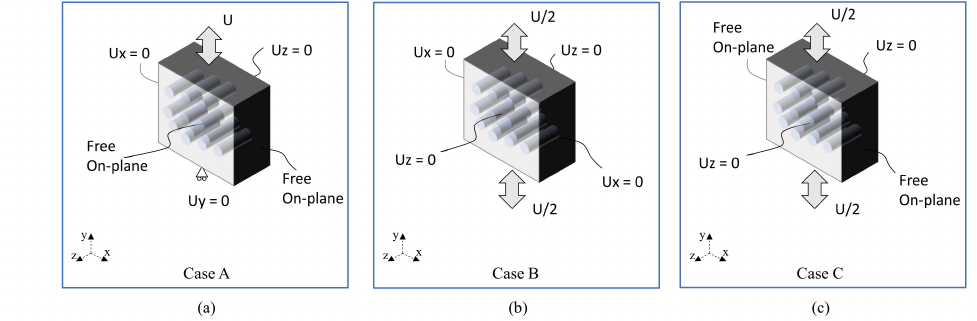
Figure 15. Non-periodic boundary conditions explored in this research: ( a ) Case A applies tensile load as in a one-eight model, ( b ) Case B applies tensile load in a transversally constrained model, and ( c ) Case C applies tensile load as in a plane strain